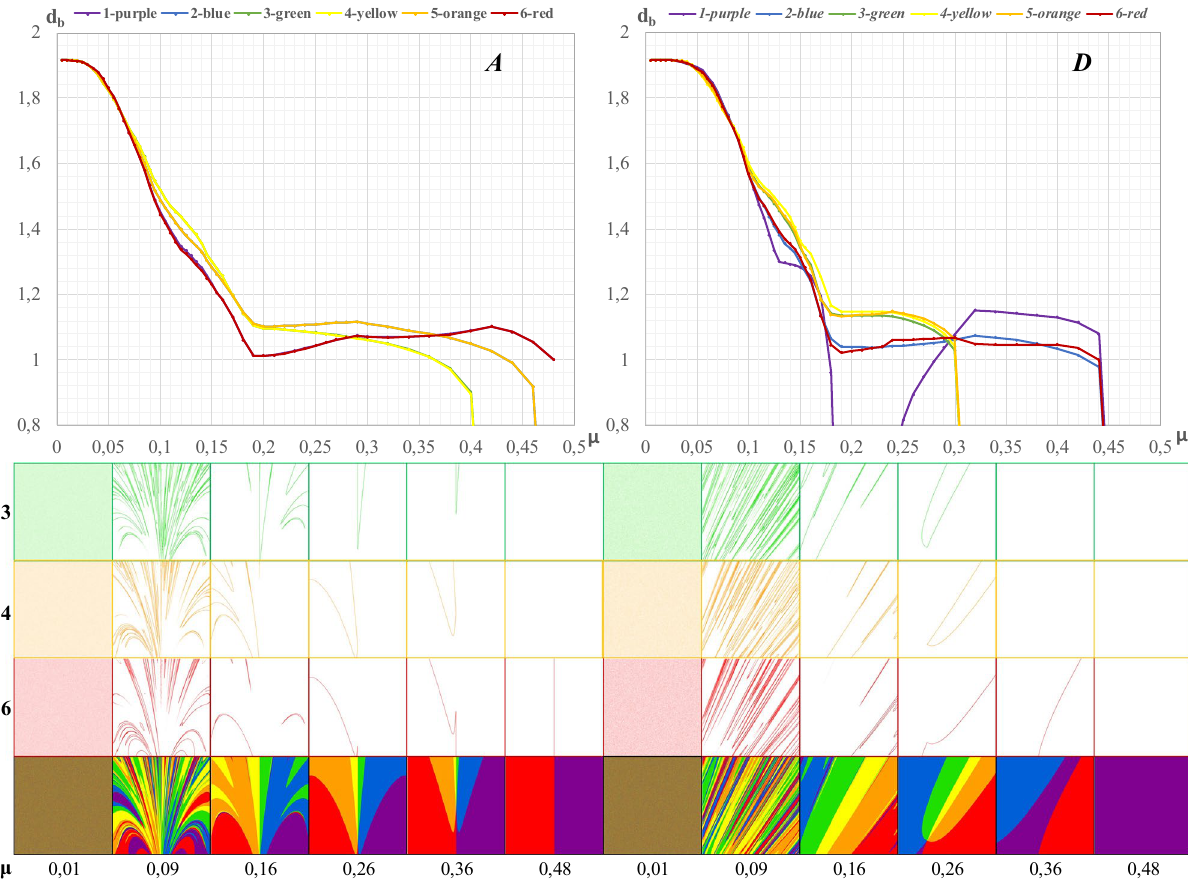
Figure 7. Box dimension of the edge of each gravitation basin in A and D . Legend: The icons show the variability of the fragments A and D due to the share of the attraction basins of individual cities (3, 4 and